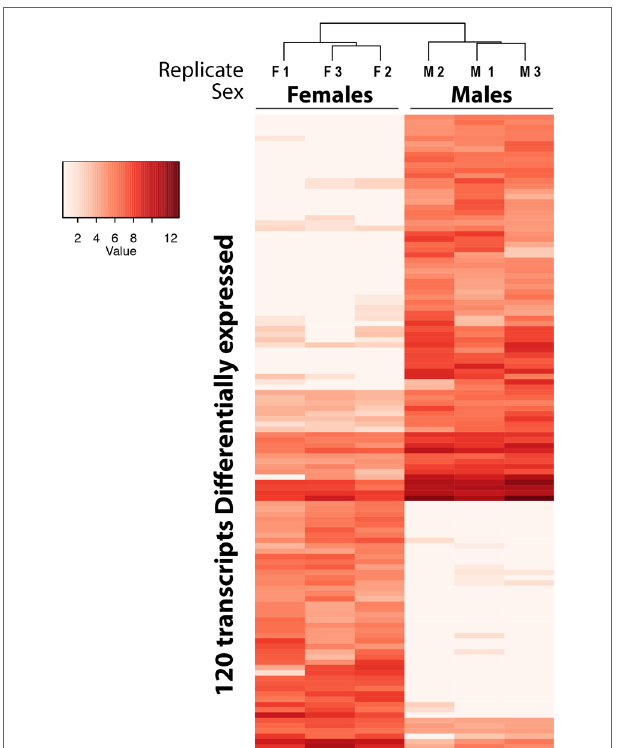
FIGURE 1 | Heatmap based on the differentially expressed transcripts (DE) between females and males of A. lixula . The clustering on the top of the heatmap represents the similarity among the samples analyzed. F1-F3 and M1-M3 represent the three female and three male replicates, respectively. The term “Value” represents the gene expression